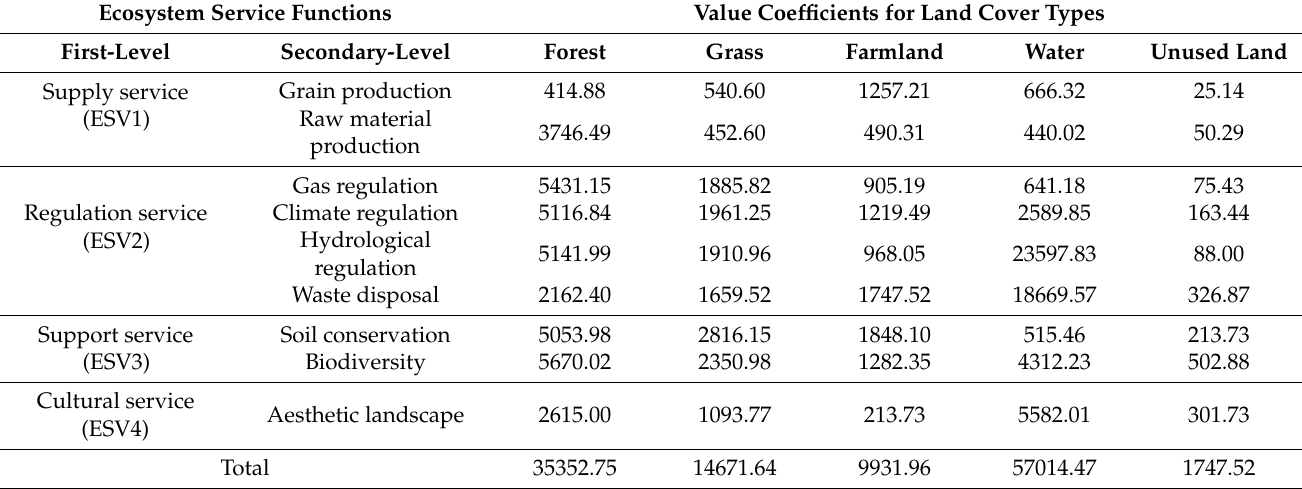
Table 1. Value coefficients of ecosystem service function types for land cover types in Dabie Mountains (CNY/ha ·